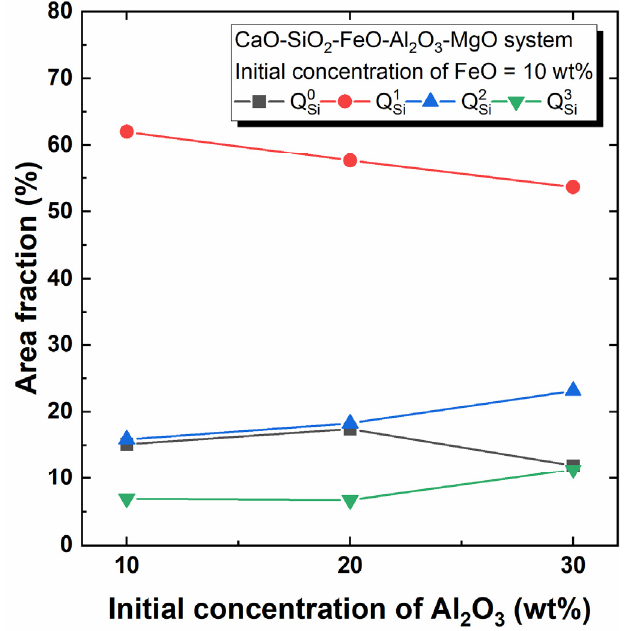
Figure 7. Relationship between relative area fractions of silicate tetrahedral structure ( 𝑄 (cid:3020)(cid:3036)(cid:3041) ) and initial concentration of Al 2 O 3 in the CaO–SiO 2 –FeO–Al 2 O 3 –MgO slag system at a fixed initial concentration of 10 wt% FeO.